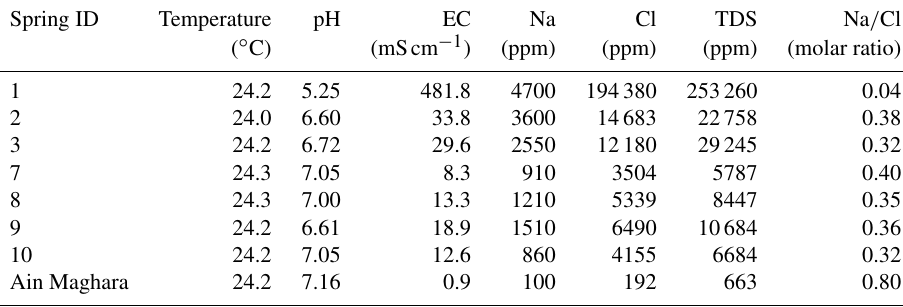
Table 1. Water geochemistry of samples taken from groundwater springs during the 1999 field campaign of Sawarieh et al. (2000). Spring ID numbering is that used in the 1999 field campaign report; spring locations are shown approximately in Fig. 1b. Spring ID Temperature pH EC Na Cl TDS (mScm − 1